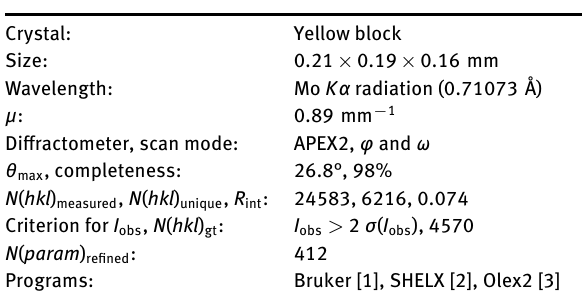
Table 1: Data collection and handling.